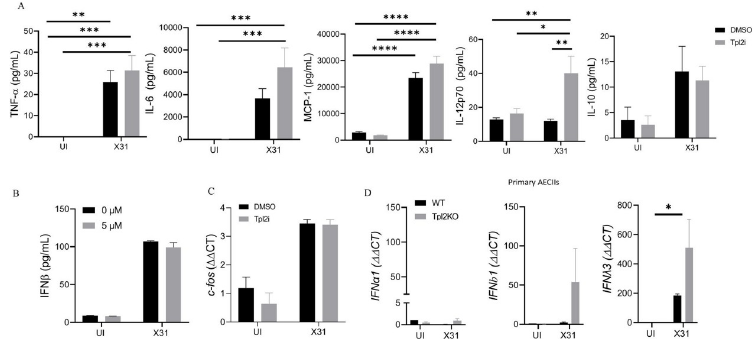
Fig 5. Tpl2 does not regulate type I IFN responses in LET1s in response to influenza infection. LET1s were cultured for 24 hours prior to stimulation with a MOI of 0.5 of influenza A/x31 (H3N2) for 24 hours after a 30-minute pre-treatment with DMSO vehicle control or Tpl2 inhibitor (5 μ M). (A) Cytokine expression measured by CBA analysis from supernatants collected 24 hpi. Pooled data from 3 experiments. (B) IFN- β secretion was measured by ELISA from supernatants collected 24 hpi. Data are representative of 3 independent experiments. (C) c-fos levels were quantified by RT-PCR from RNA lysates collected 24 hpi. Pooled data from 3 experiments. (D) Primary AECIIs were isolated from influenza-infected WT or Tpl2 -/- mice at 3 dpi. IFN- α 1, IFN- β 1, and IFN- λ 3 expression levels were quantified by RT-PCR from primary AECII RNA lysates.